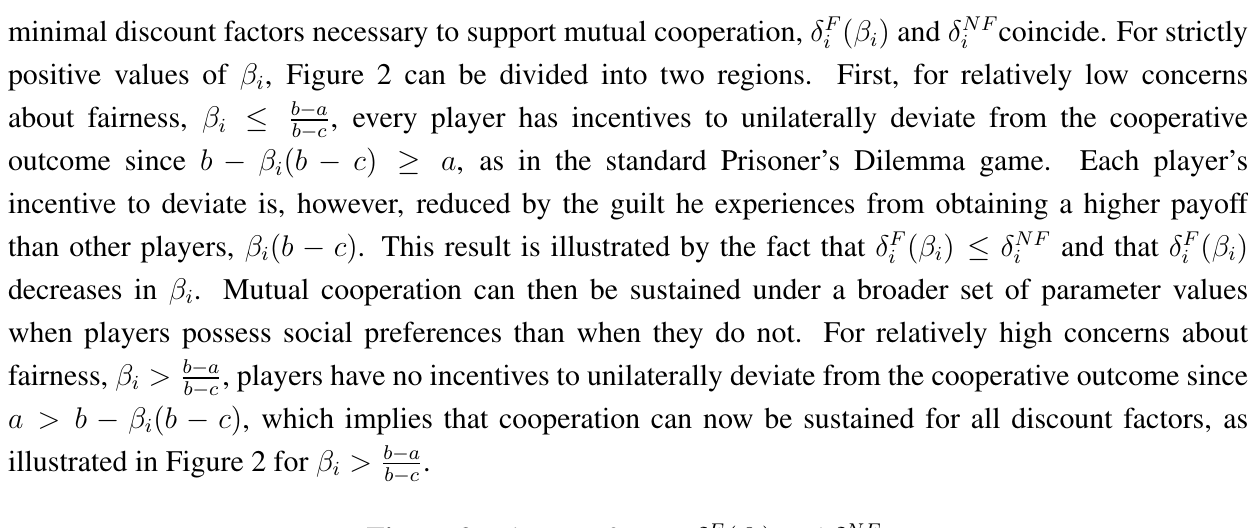
Figure 2. Discount factors δ F